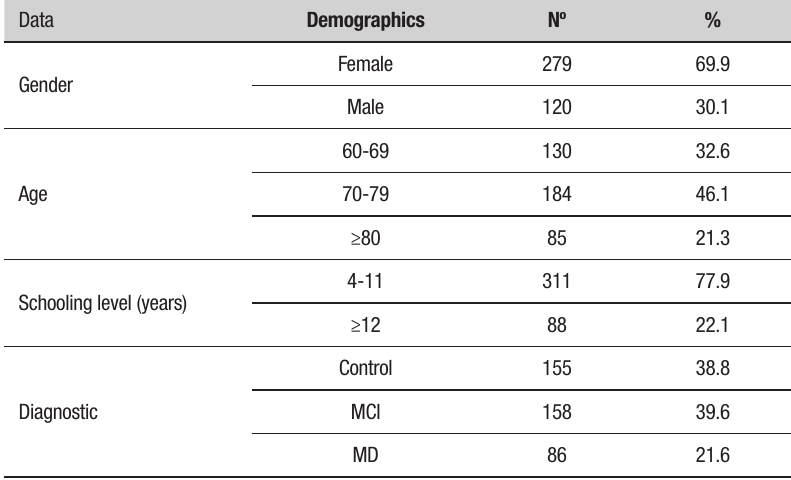
Table 1. Demographic